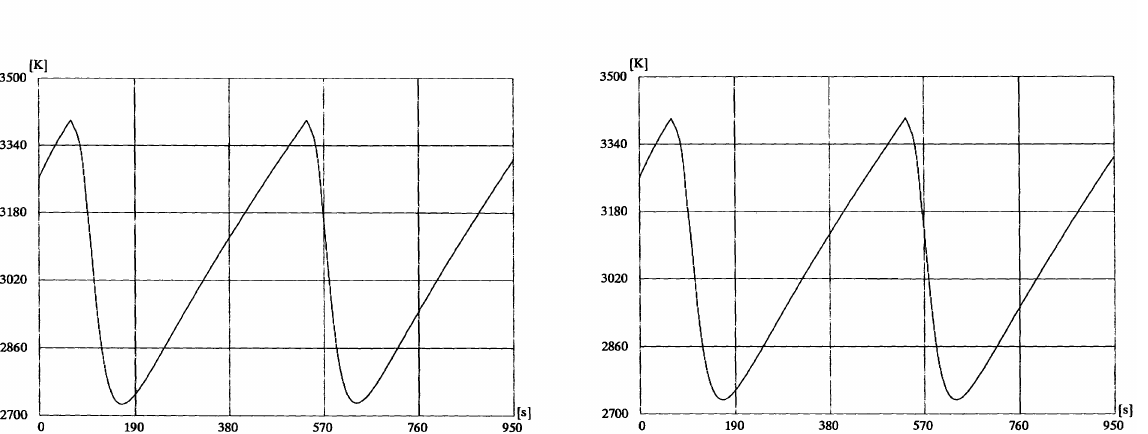
FIGURE 4 Change of maximum temperature at er ror e = 60 (W